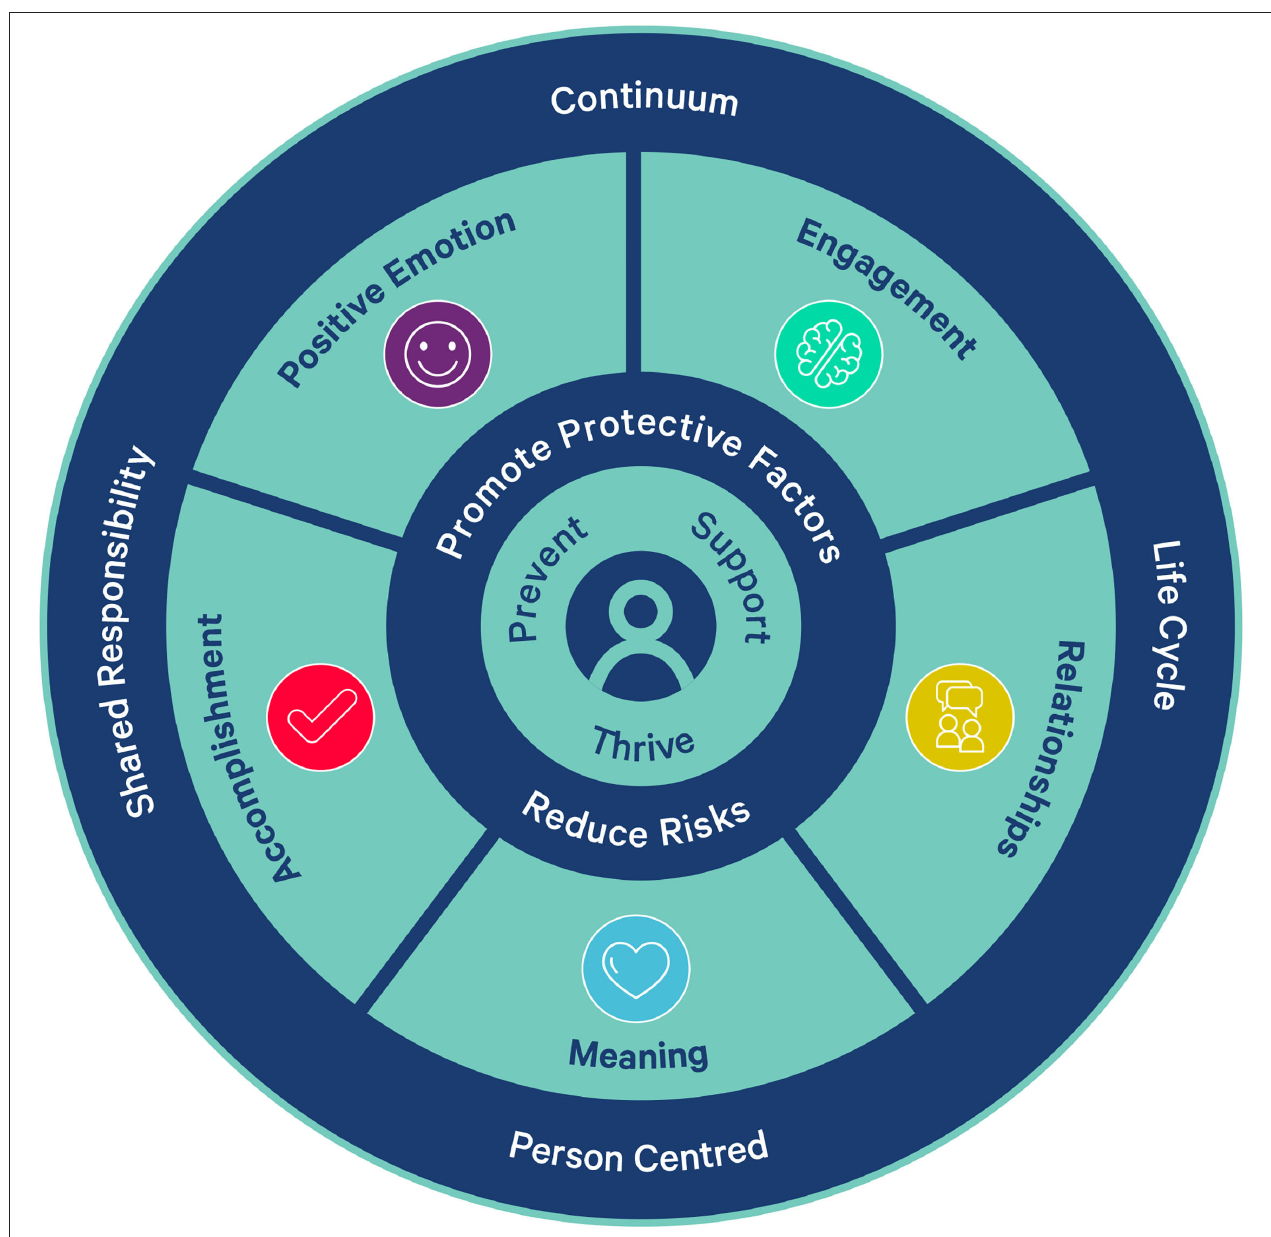
FIGURE 1 | Mental fitness